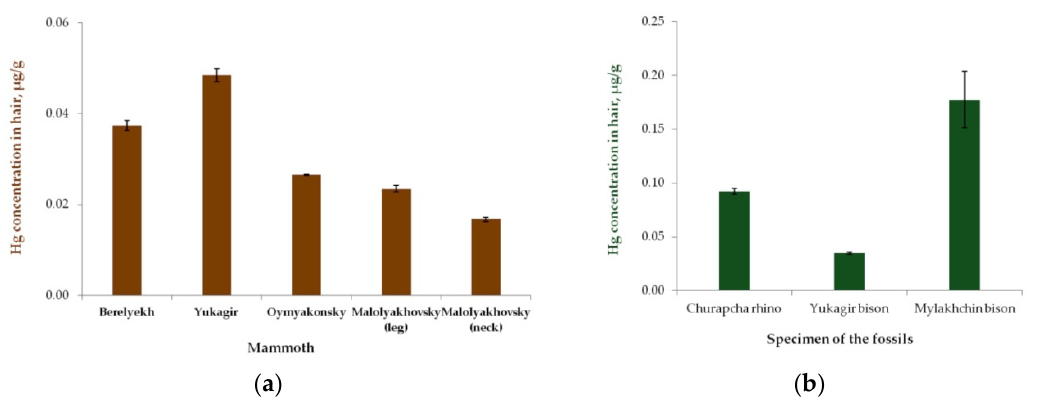
Figure 3. Mercury concentration in hair of different fossil specimens: ( a ) mammoth; ( b ) bison and rhino.